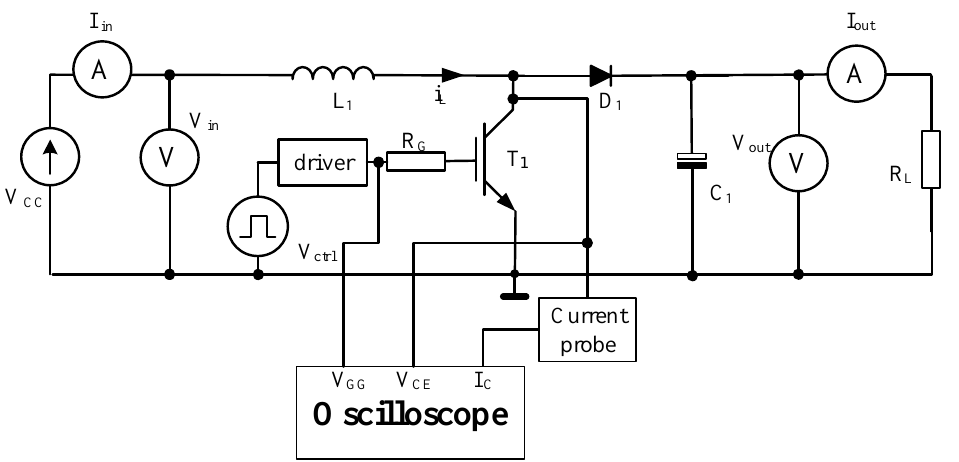
Figure 4. Diagram of the tested boost converter.